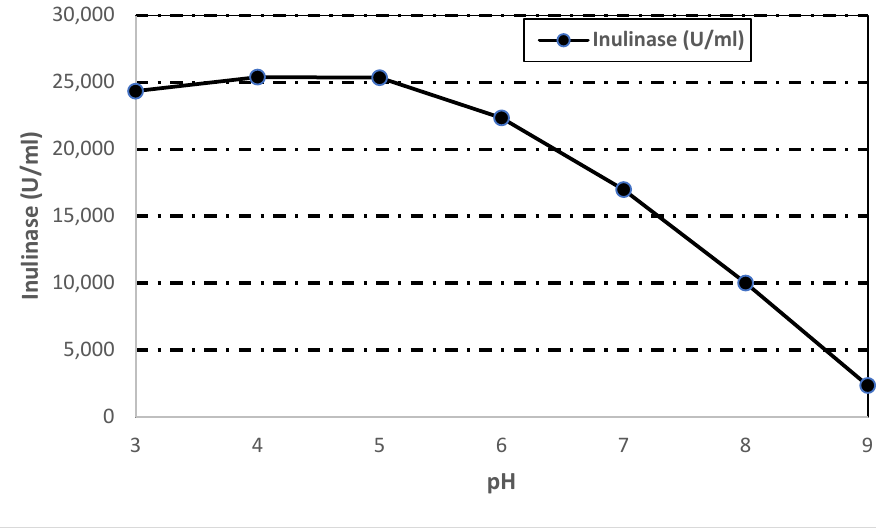
Figure 6. pH stability of the purified inulinase from Rhizopus oryzae NRRL 3563.